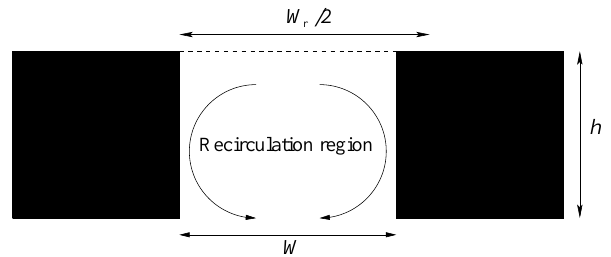
Figure 1. Narrow canyon leading to a skimming